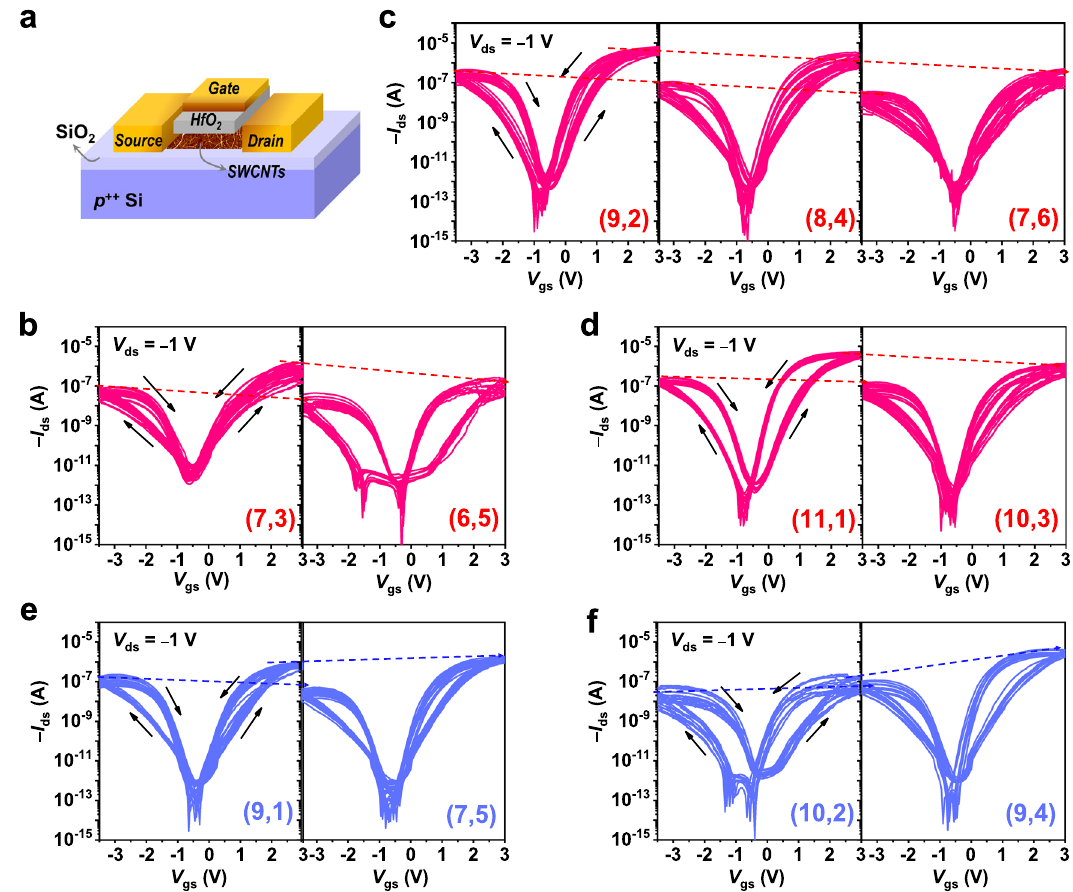
in ( b – f ) represent the forward and reverse scanning directions of the gate voltage V gs .Dashedlinesareusedforthecomparisonoftheon-statecurrentsforthesame- family